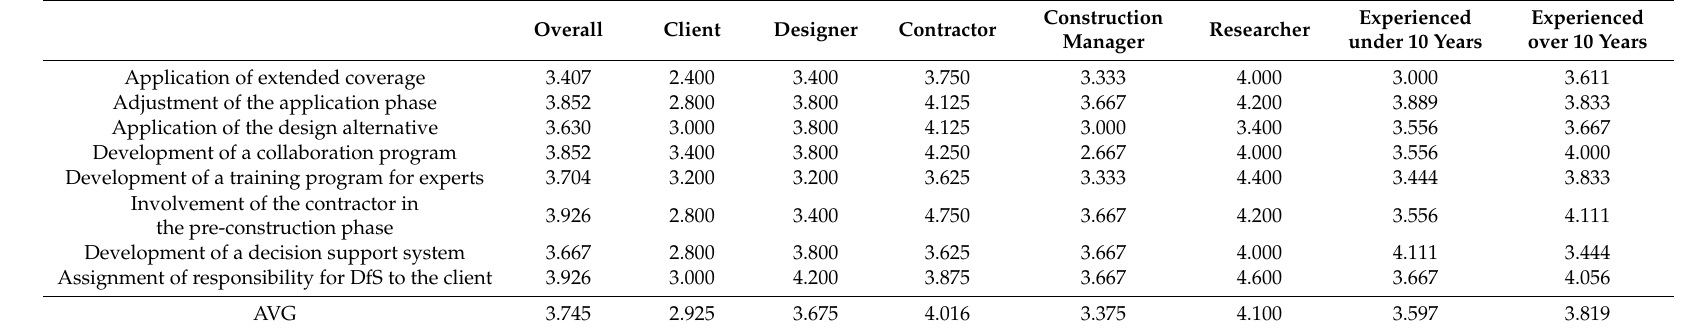
Table 6. Results of the absolute importance of the DfS improvement